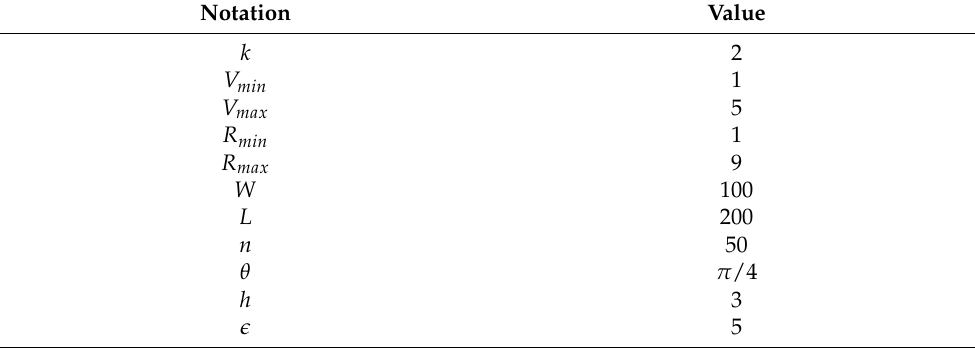
Table 2. Simulation values.